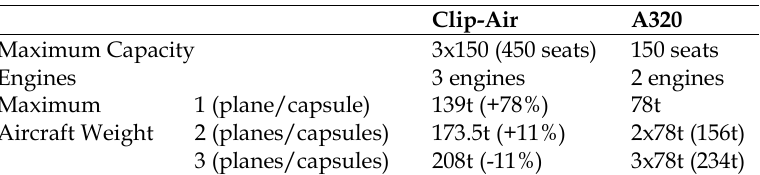
Table 3. Clip-Air